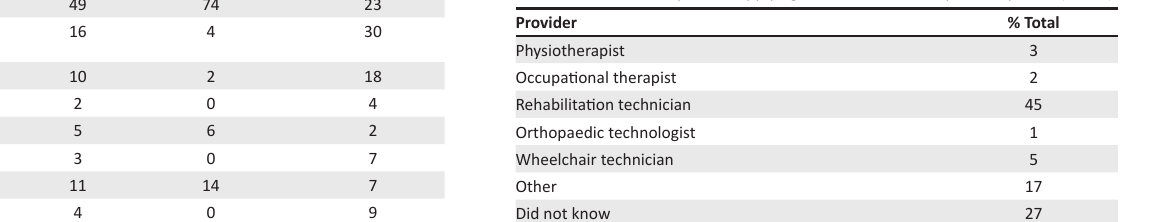
TABLE 1: Health conditions necessitating the use of a wheelchair ( n = 94). Condition